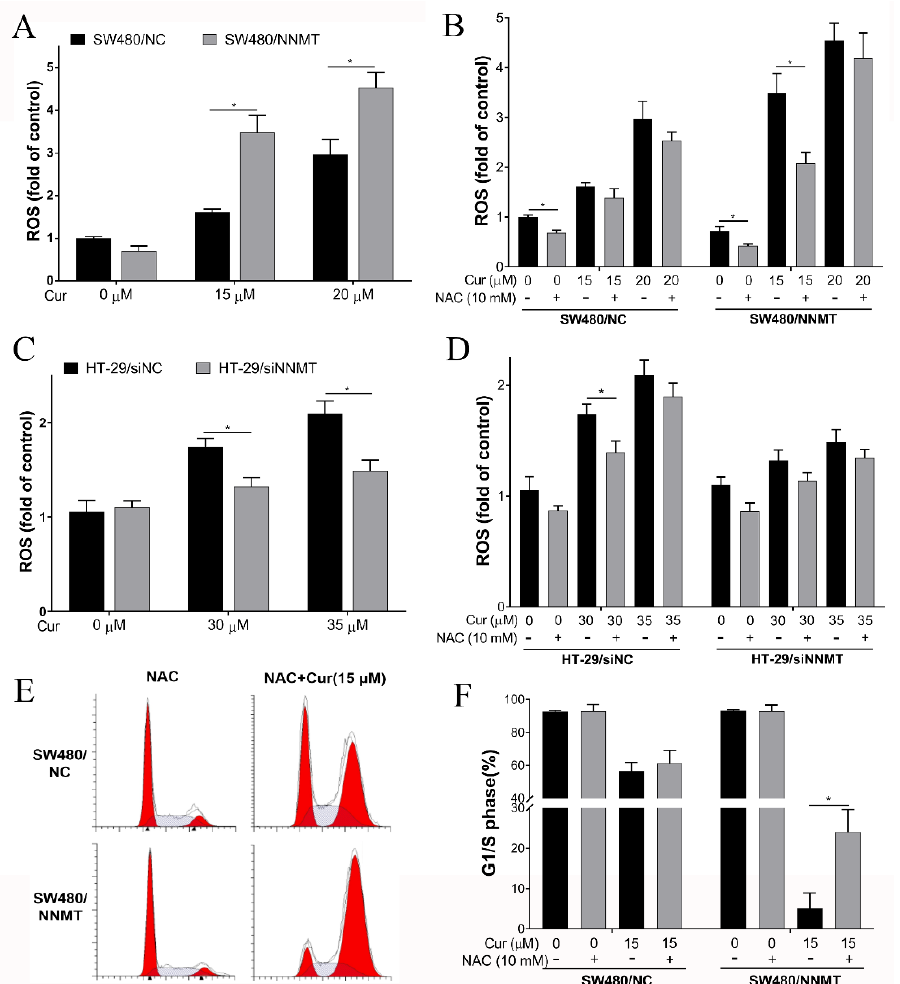
Figure 7. Cur induces cell cycle arrest by increasing ROS generation. Cells were pretreated with 10 mM NAC for 2 h and/or following treatment with Cur for 24 h. ( A , B ) ROS was detected by flow cytometry using the fluorescent probe DCFH − DA and is displayed as a histogram in SW480 cell lines. ( C , D ) ROS was detected by flow cytometry using the fluorescent probe DCFH − DA and is displayed as a histogram in HT-29 cell lines. ( E , F ) Cell cycles were detected by flow cytometry and are displayed as a histogram. Cur: curcumin. +: treated, − : untreated. Data are expressed as means ± SD, n = 3, * p < 0.05.